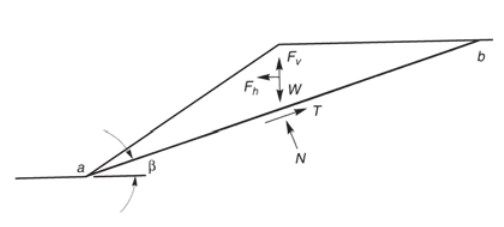
Fig. 3. Pseudostatic loads acting on a sliding